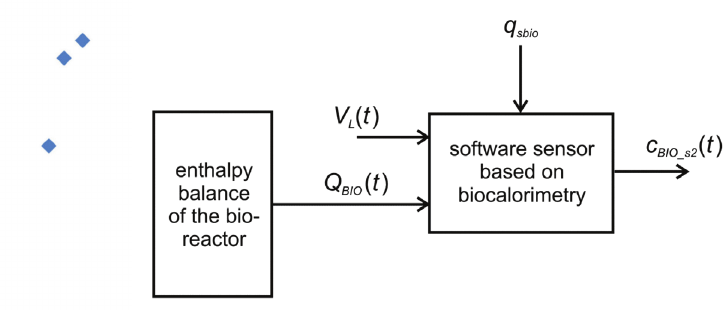
Fig. 8 – Input-output scheme of the software sensor based on